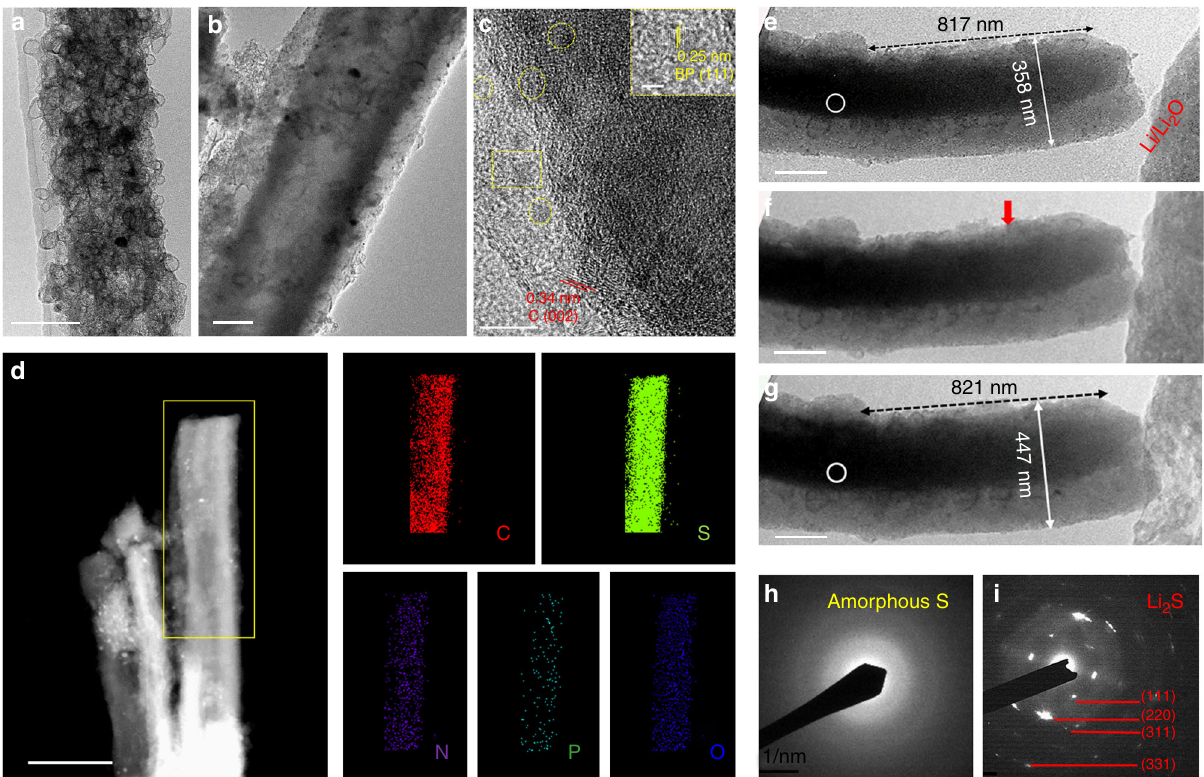
Fig. 4 Integrate black phosphorus quantum dots with porous carbon/sulfur cathodes. a Transmission electron microscopy (TEM) image of the porous carbon nano fi ber (PCNF) consisting of numerous hollow carbon spheres, b TEM image of the porous carbon host in a fi lled with sulfur particles and black phosphorus quantum dot (BPQD), designated as PCNF/S/BPQD, c high-resolution TEM (HRTEM) image showing the graphitic carbon layers of the PCNF and the uniform dispersion of BPQD within PCNF/S/BPQD, d scanning tunneling electron microscopy (STEM) image and energy dispersive spectroscopy (EDS) elemental mapping of the PCNF/S/BPQD fi bers, e – g TEM images captured during lithiation of a PCNF/S/BPQD fi ber, the red arrow in f refers to the reaction front, h , i selected area electron diffraction (SAED) patterns of the selected area with white circles in e and g , respectively. Scale bars, 100 nm ( a